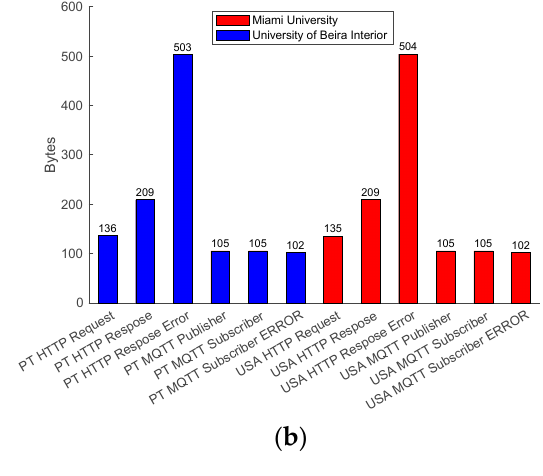
Figure 9. ( a ) Mean of iRTT delay; ( b ) packet size.